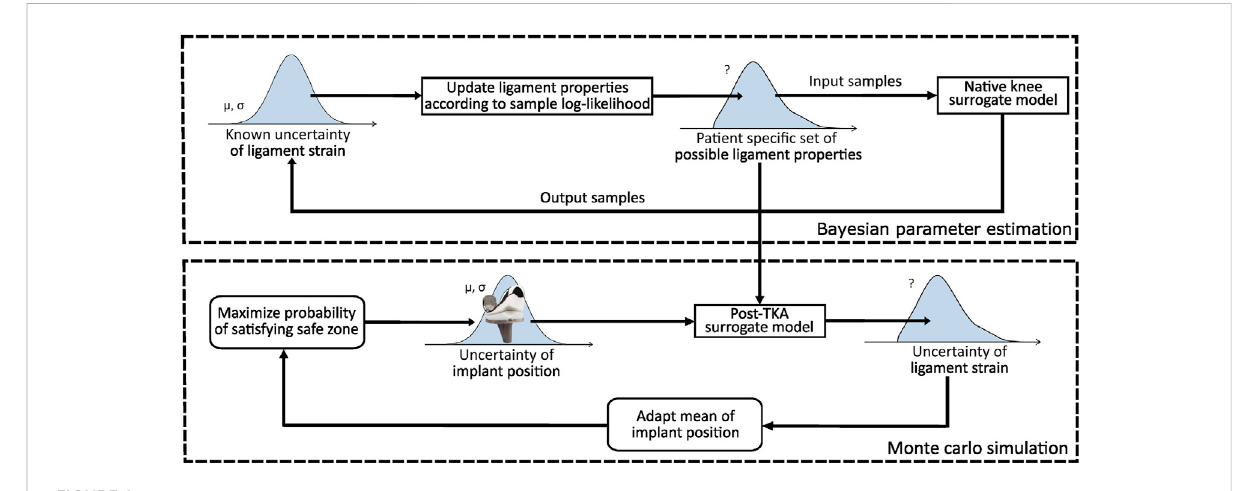
FIGURE 1 Overview of the probabilistic planning process for